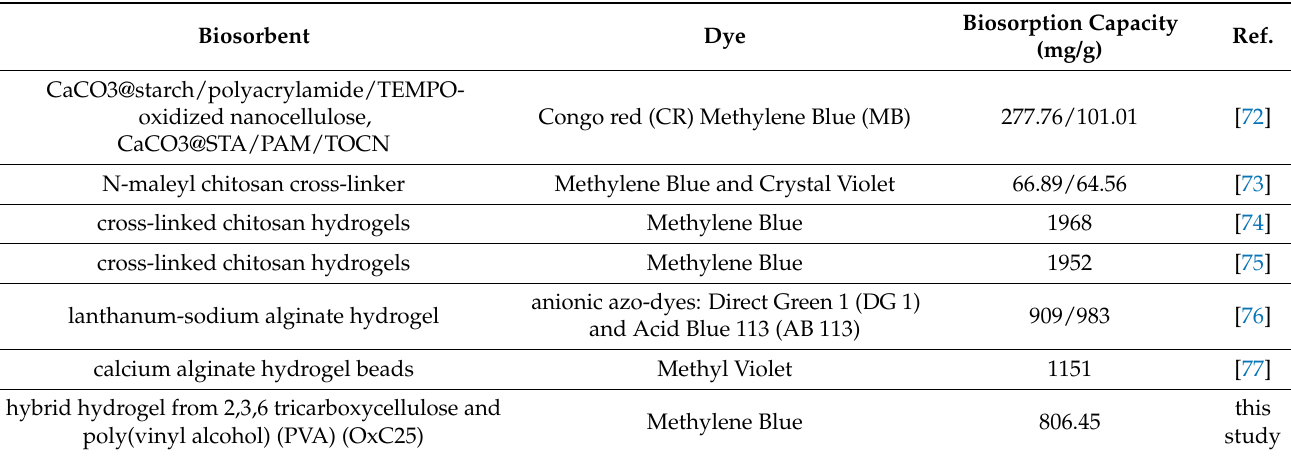
Table 2. Achieved biosorption capacities while employing hydrogel as a biosorbent to retain dyes.